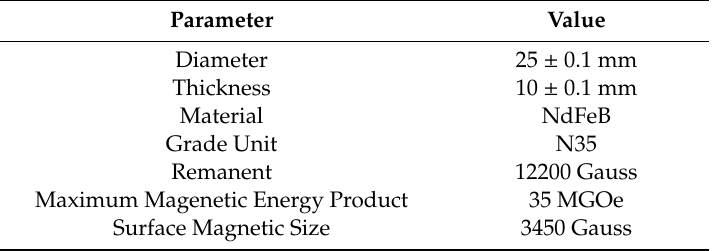
Figure 5. Comparison of deep displacement measurement range and permanent magnet size. “20X5”means the size of permanent magnet is 20 mm in diameter and 5 mm in height, and so on. “N35” and “N52” represent different materials of the permanent magnet. Table 1. Size and parameters for the selected permanent